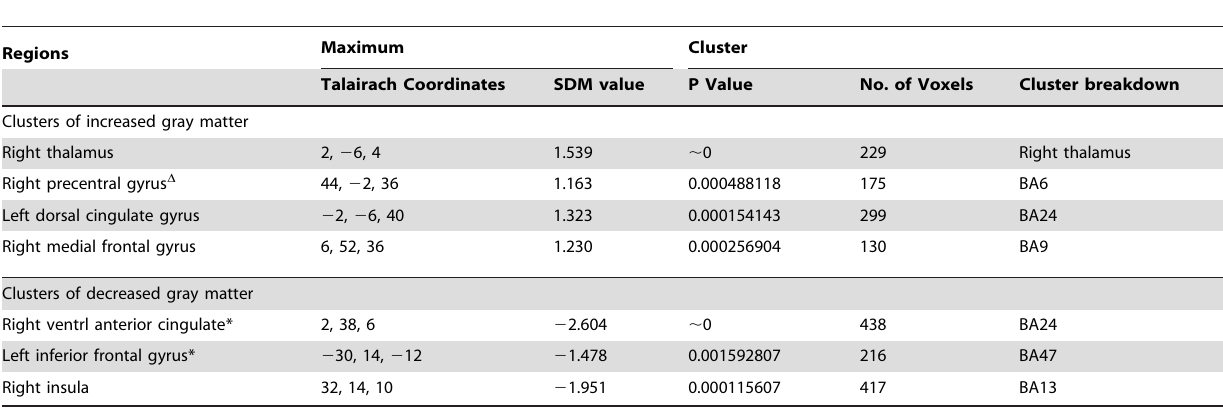
Table 4. Regions With Significant Differences In Gray Matter Volumes Between Drug-naı¨ve Patients With Anxiety Disorders Comorbid Depression And Healthy Controls.